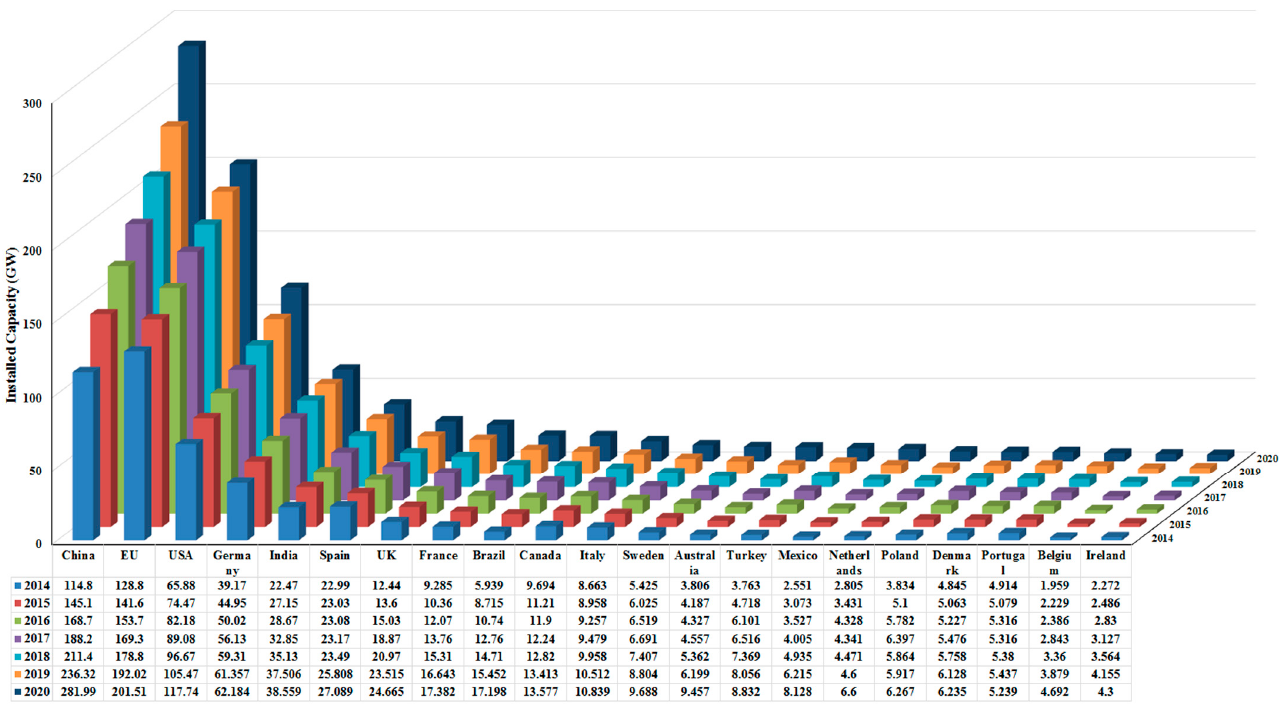
Figure 7. Growth of wind power installation capacities of foremost countries in MW (as on 31 December 2020). Source: The wind power; wind farms and wind-turbines database [30]. Worldwide, the biggest wind power plant (as on 20 January 2021) is Jiuquan Wind Power Base (JWPB) located in Gansu Province, China, with a 20 GW generation capacity. During the past two to three years, China has maintained its top position in the installation of the highest number of wind power plants with the highest installed capacity [31-36]. The second biggest wind power plant in the world is situated in the Rajasthan state of India, which produces 1600 MW of wind energy. The top 10 largest wind power plants